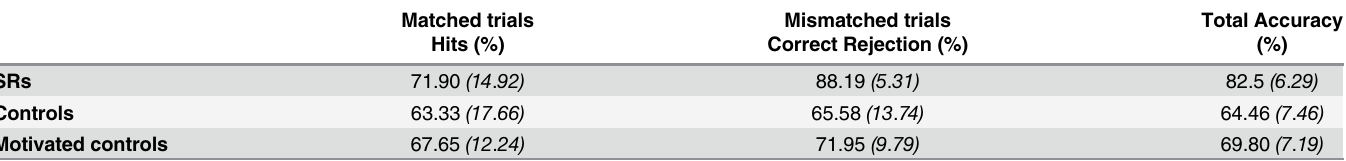
Table 4. Group accuracy descriptive statistics in MFMT Standard deviations are in